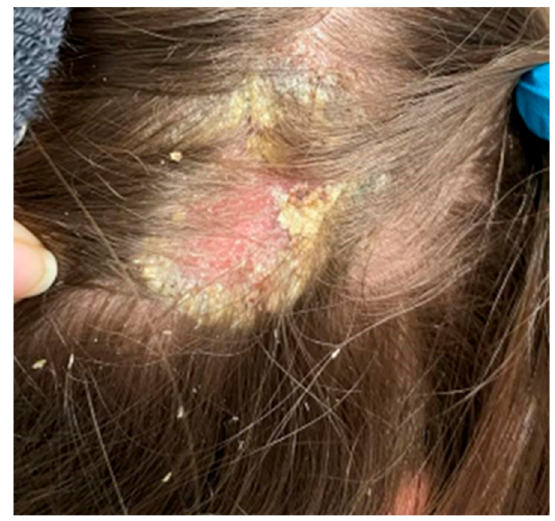
Figure 6. In the right parietal area, erythema covered with greasy yellowish scales, with swollen skin and subcutaneous tissue.